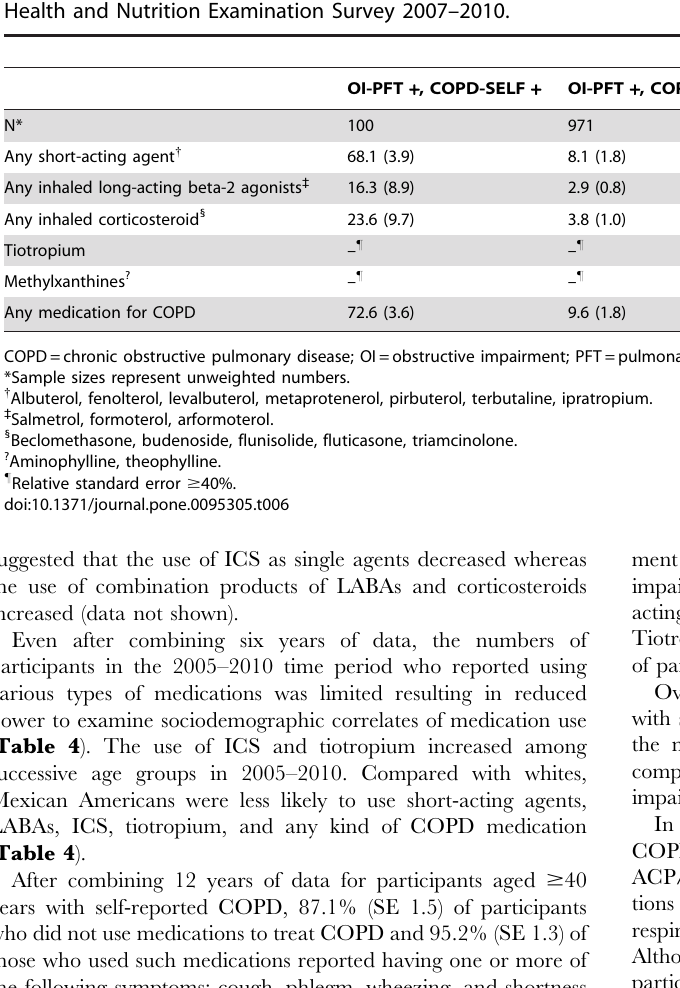
Table 6. Age-adjusted percentages (standard error) of adults aged 20–79 years taking prescription medications for chronic obstructive pulmonary disease, by obstructive impairment and self-reported chronic obstructive pulmonary disease, National Health and Nutrition Examination Survey